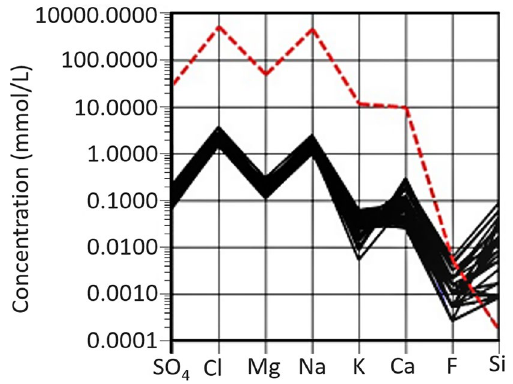
Figure 2. Lake waters sampled from Macquarie Island represented as a Scholler plot with the red dashed bolded line representing seawater composition and black lines are lake water concentration of SO 4 , Cl, Mg, Na, K, Ca, F and